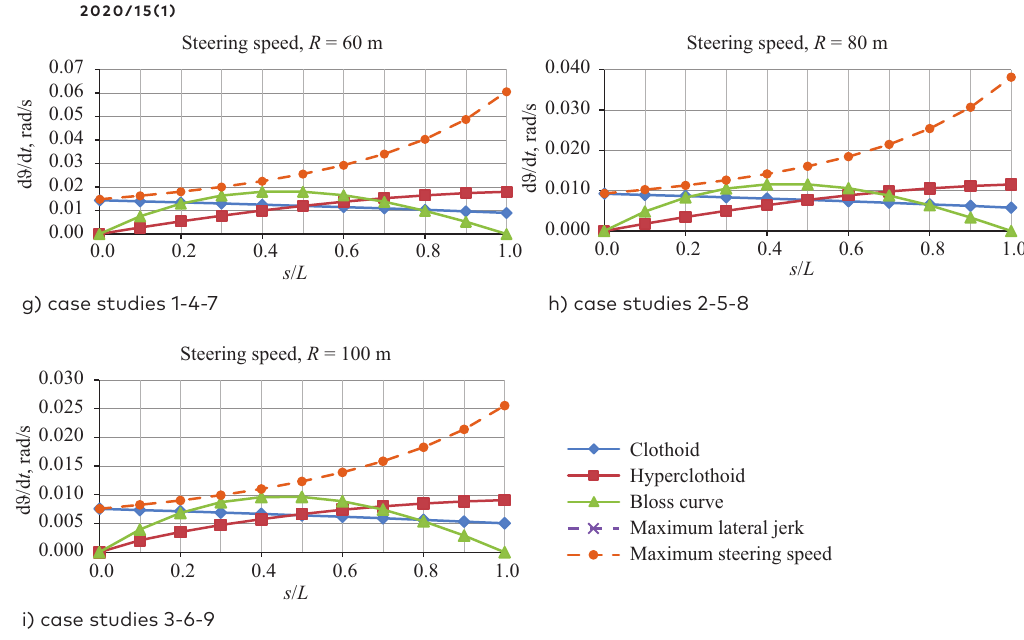
Figure 6. Kinematic checks and comparisons between different